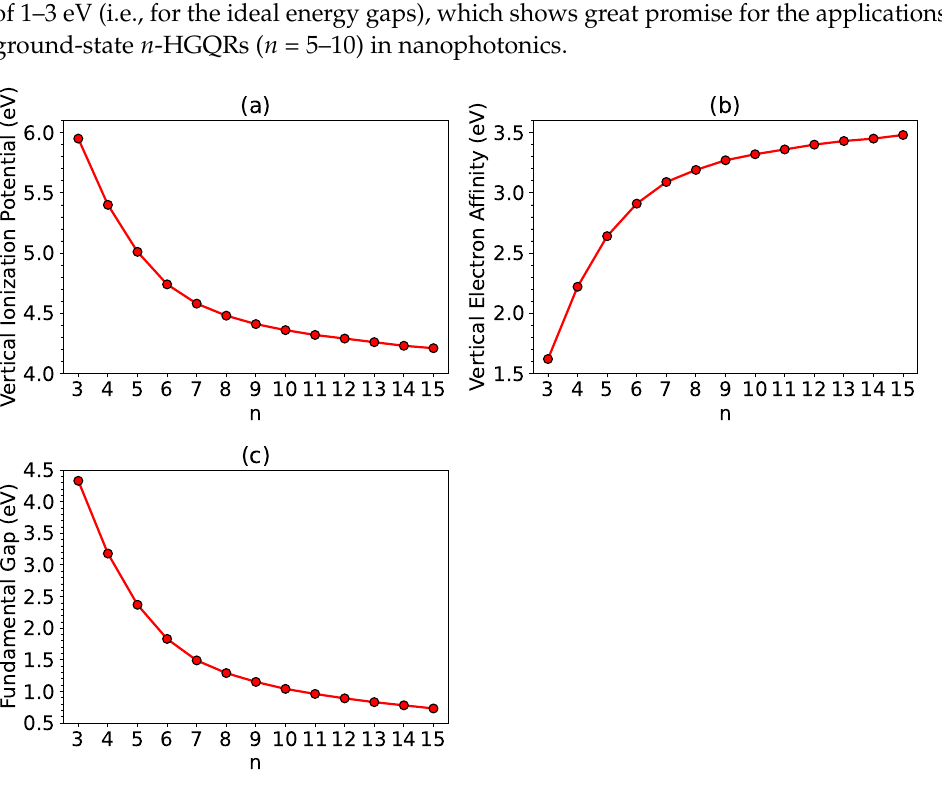
Figure 3. ( a ) Vertical ionization potential, ( b ) vertical electron affinity as well as ( c ) fundamental gap associated with ground-state n -HGQR, calculated by spin-unrestricted